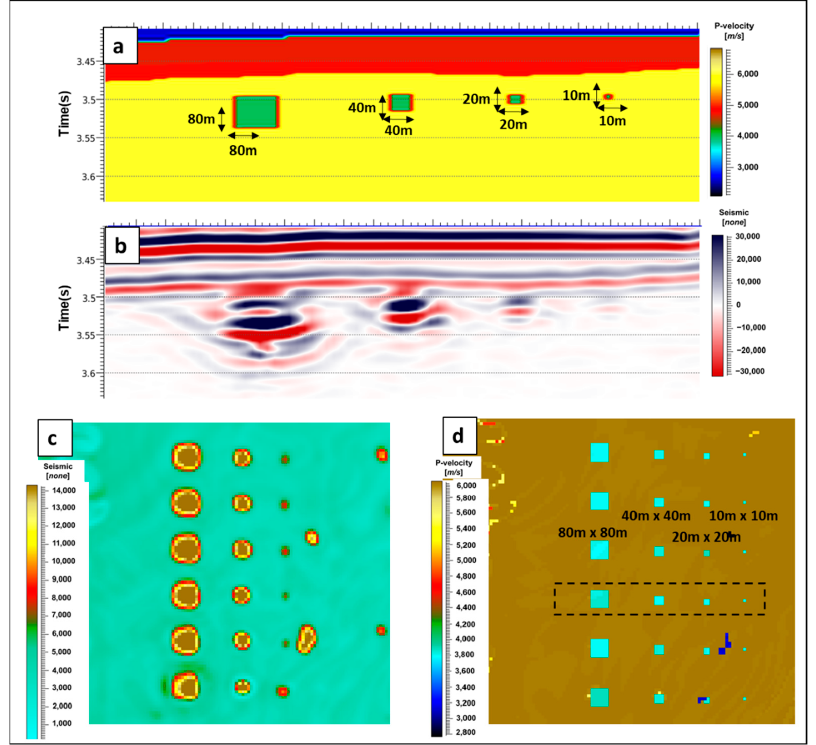
Figure 2. Model of caves of different sizes and depths. Geological model 2: ( a , d ) geological models; ( b ) seismic models; ( c ) RMS amplitude map.